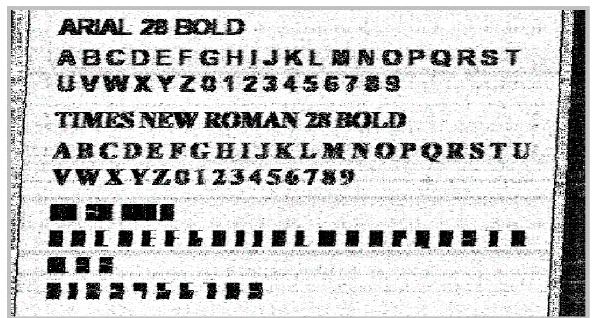
Figure 20. Font 28 with blank spaces: Arial, TNR and secure asymmetrical—bold with blank spaces.